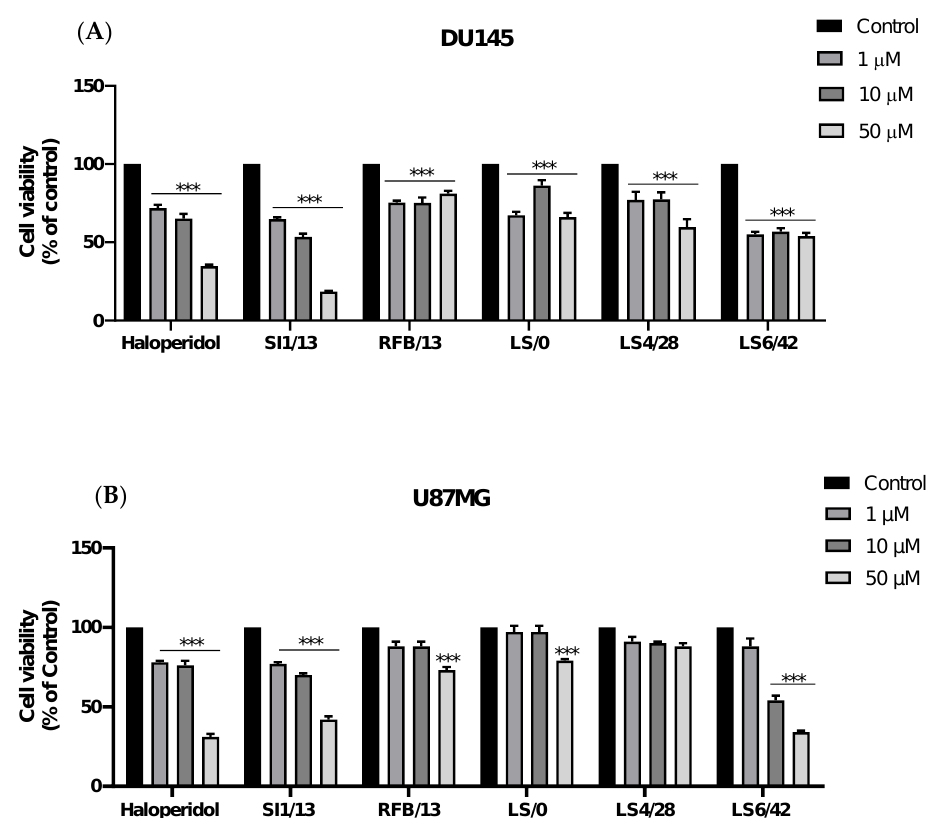
Figure 3. Effect of σ R ligands haloperidol, SI1/13 and RFB/13 and of HO-1 inhibitors LS/0 , LS4/28 and LS6/42 treatments on cell viability of DU145 (panel A ) and U87MG (panel B ) cell lines, assessed by MTT assay at the doses of 1, 10 and 50 µ M. Results are representative of at least three independent experiments and values are expressed as percentage of control (% of control). Data represent means ± SEM. *** p < 0.001 vs. control as determined by One- way ANOVA followed by Tukey’s multiple comparison test.